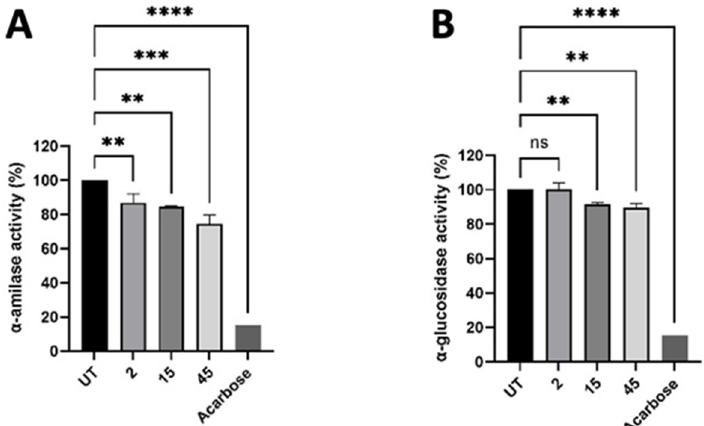
Figure 8. Effect of γ -C-derived peptides at 2, 15, and 45 min of digestion on α -amylase ( A ) and α -glucosidase ( B ) enzymes’ activity. Values are mean ± standard deviation of three independent experiments. **** p ≤ 0.0001, *** p ≤ 0.001, ** p ≤ 0.01. ns states for not significative.